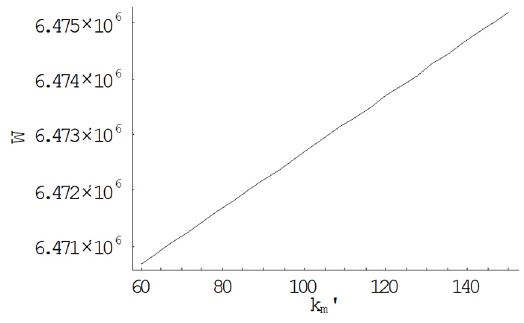
Figure 5. Total cost versus carbon emission parameter h m ’ .